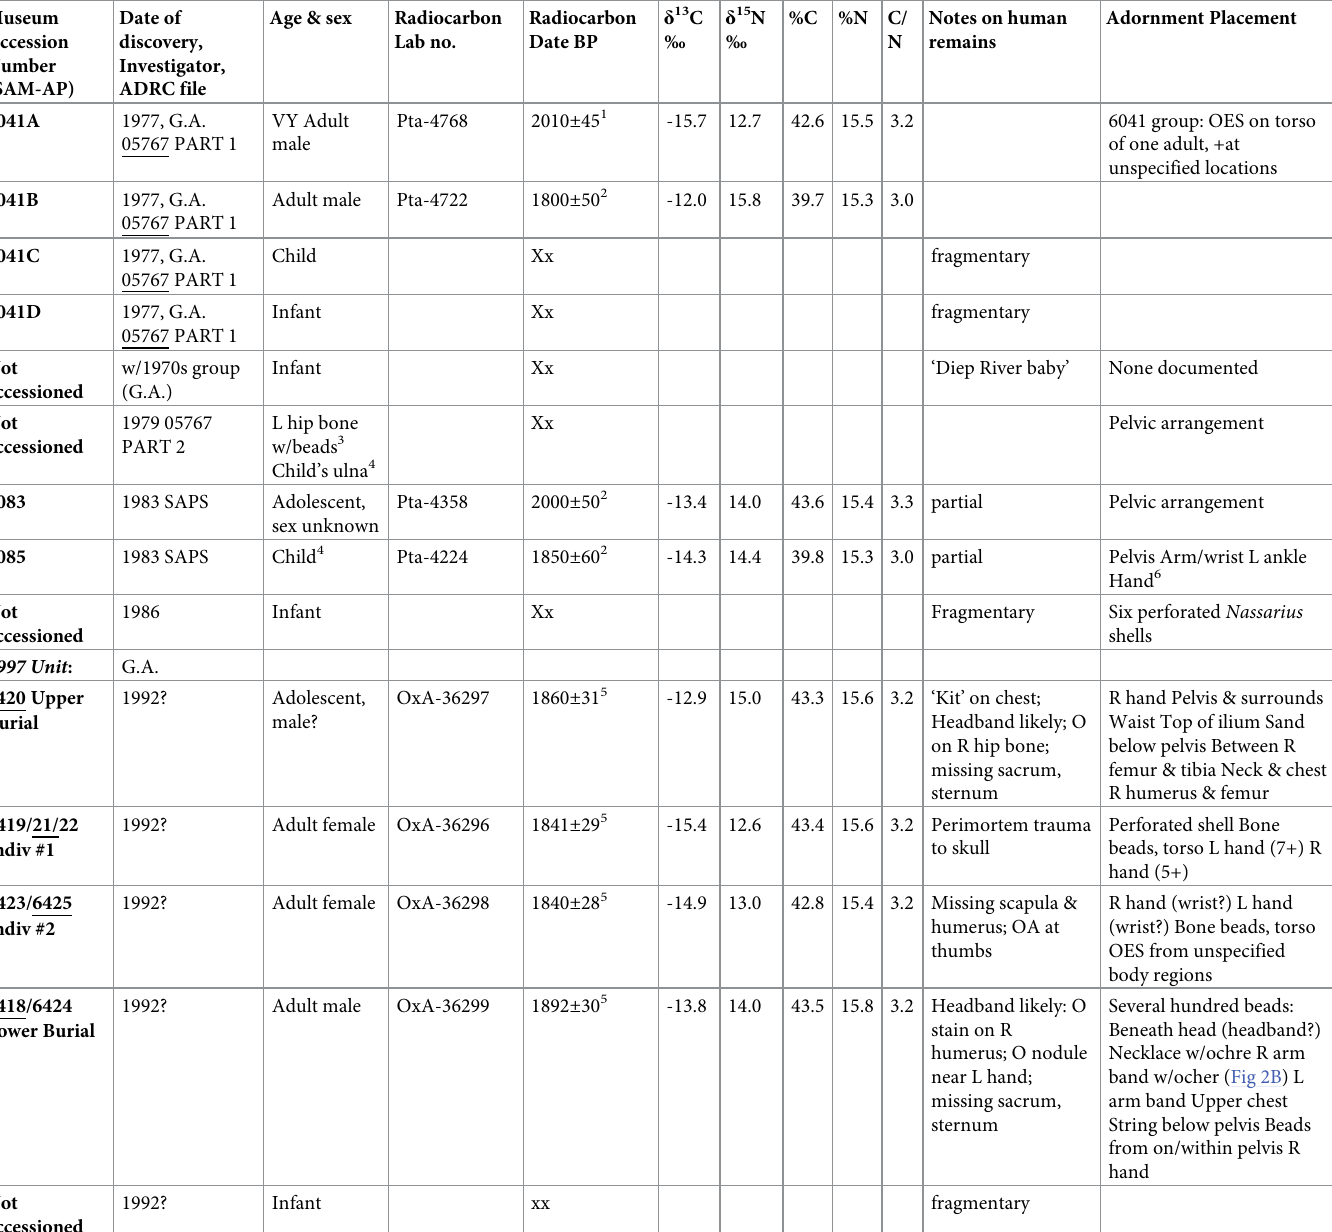
Table 1. Lagoon Beach burials included in this study. All were discovered approximately 200 meters south of the Diep River (Milnerton) lagoon, eroding from coastal dunes. Information on adornment is from museum notes and extant holdings. Unless otherwise indicated, beads are OES. Within the 1997 unit, the catalogue unit that includes the skull is underlined. O = ochre; G.A. = Graham